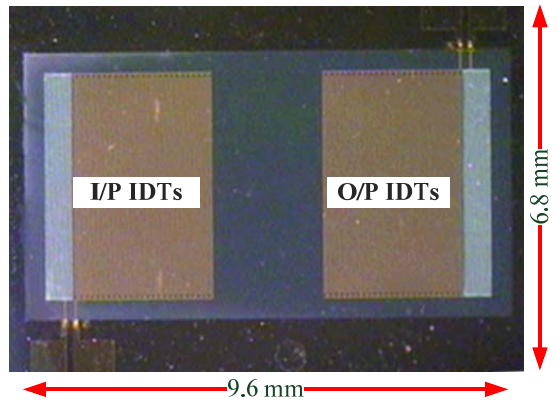
Figure 15. Photograph of the implemented FPW